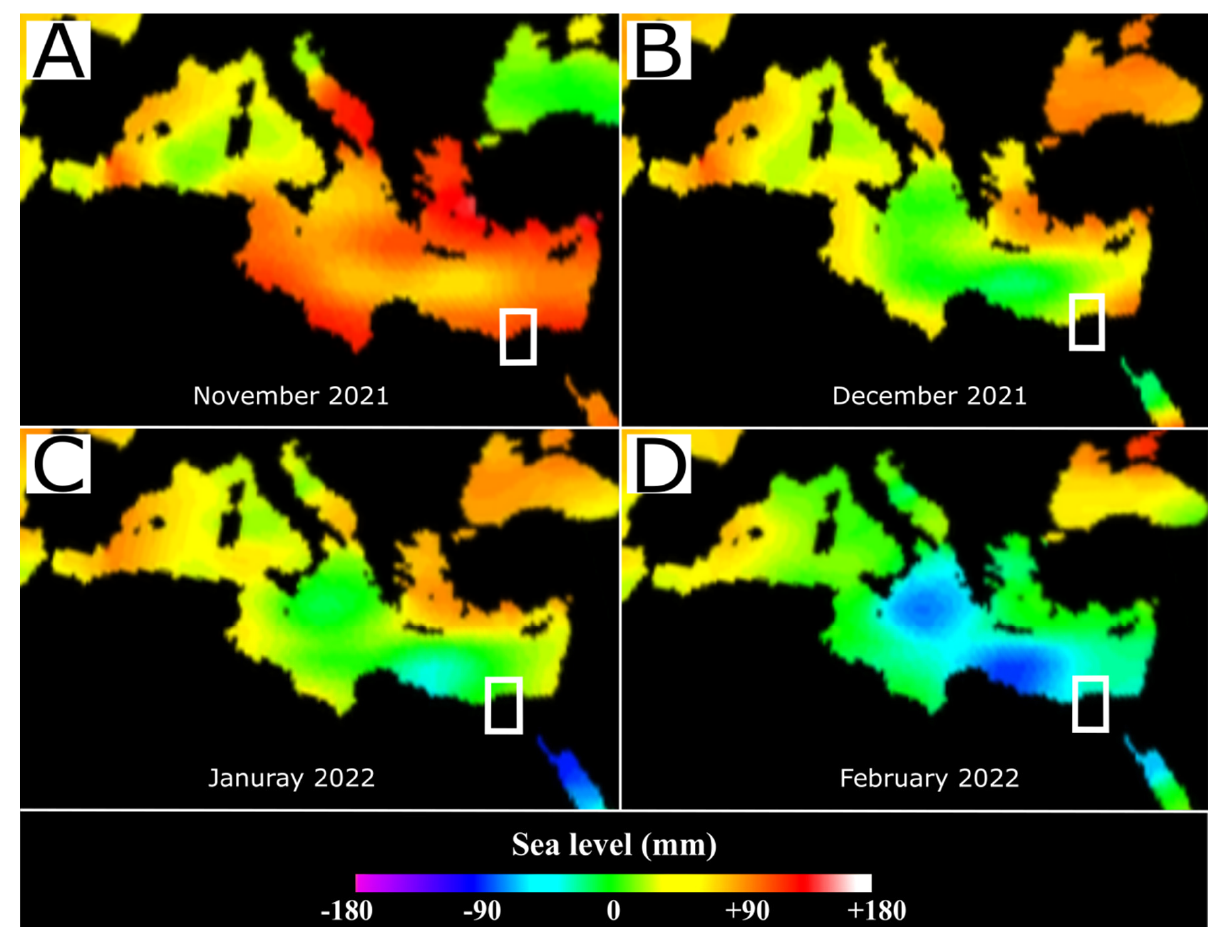
Figure 6. ( A – D ) Satellite images for the average monthly sea level rise variations; the pinkish rec- tangle refers to Alexandria. From https://climate.nasa.gov/, accessed 13 May 2022.